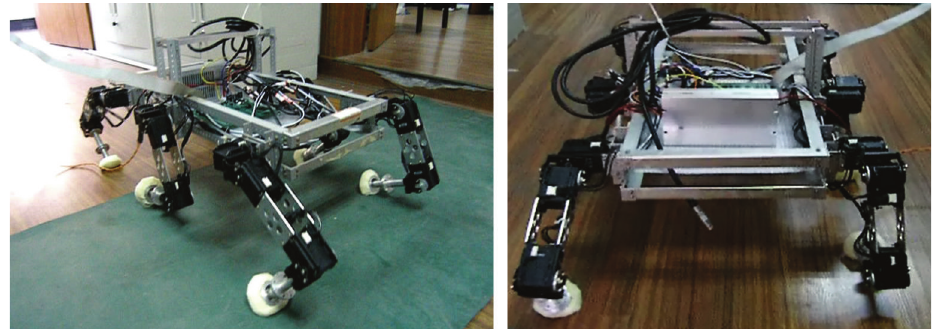
Figure 1: Mechanical model of hexapod transport